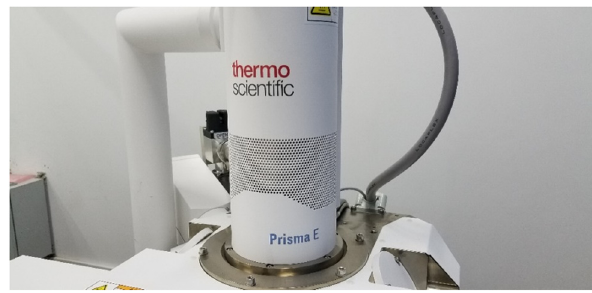
Figure 12: Orthogonal test